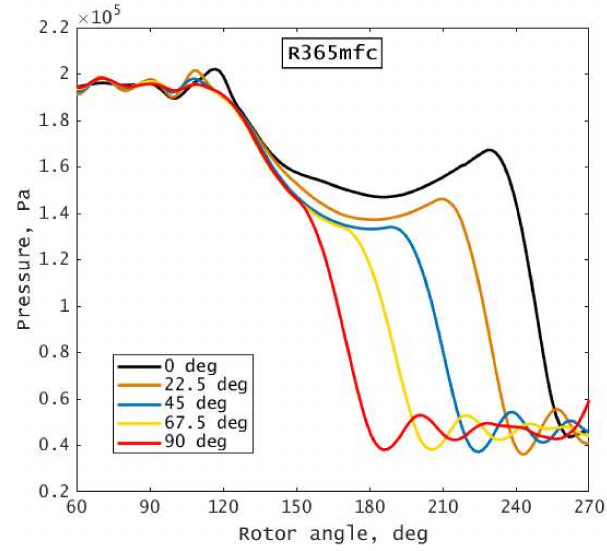
Figure 9. Pressure variation in a working chamber for R365mfc and different outlet port